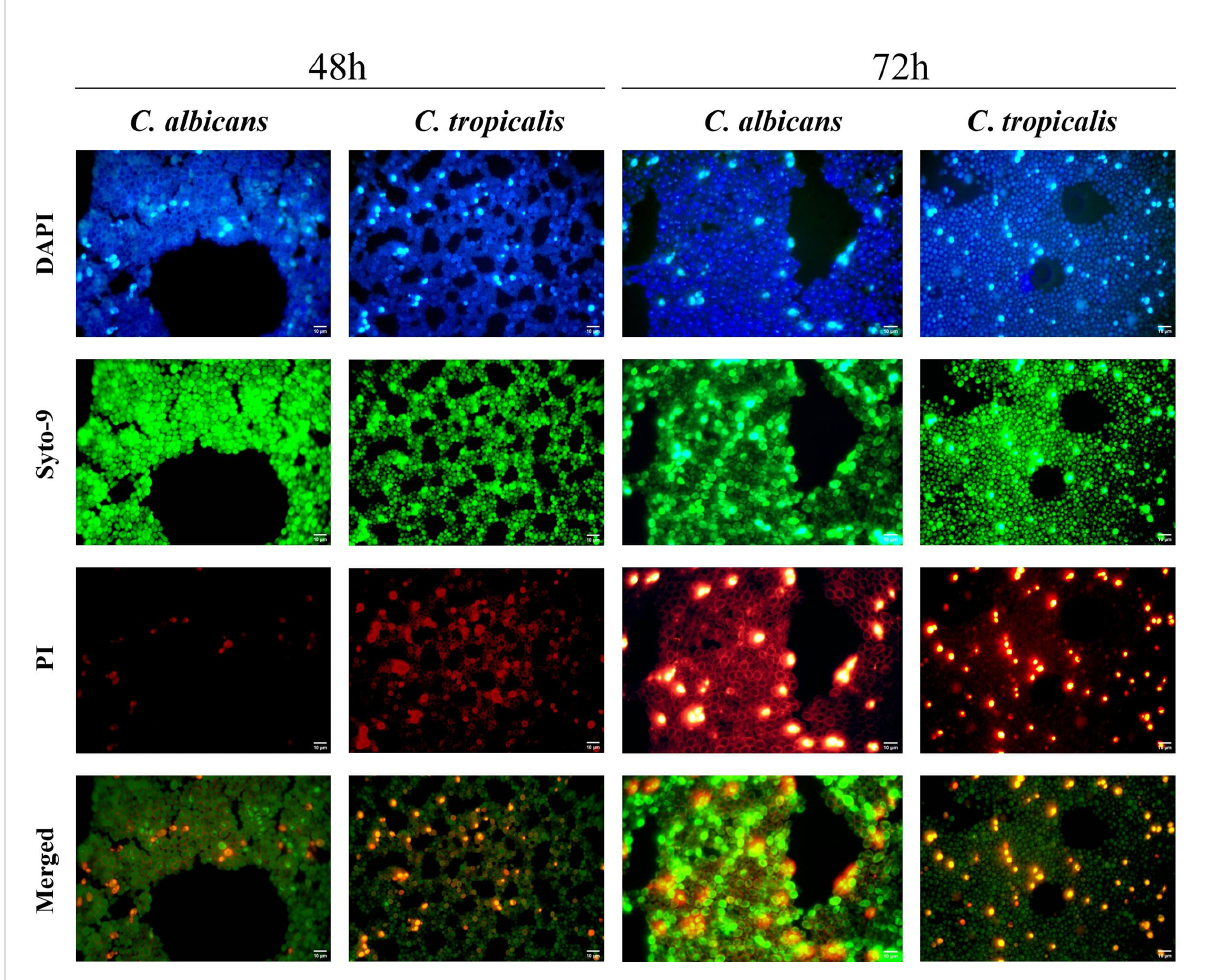
FIGURE 2 Illustration of the bio fi lms of C. albicans and C. tropicalis at 48 and 72 h of growth by epi fl uorescence microscopy using 4 ′ ,6-diamidino-2- phenylindole fl uorescent stain and LIVE/DEAD Bio fi lm Viability Kit. Time samples of 48 and 72 h were used to compare the total cell and live/ dead cells in the bio fi lms using an Olympus BX50 microscope, and pictures were obtained by AmScope software at ×100 magni fi cation. Then, the pictures from each fi lter were merged in Fiji-ImageJ version 1.57 (Schindelin et al.,